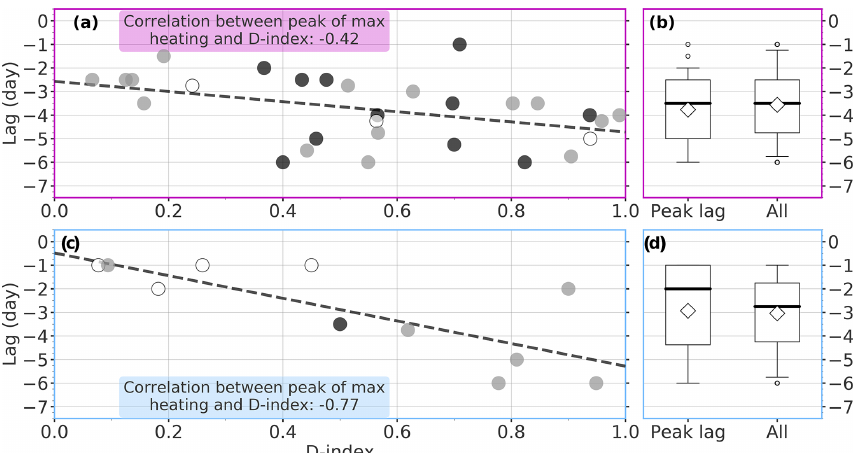
Figure 12. Correlation between life stage of the Ural (first row, magenta) or Scandinavian (second row, light blue) blocks and the time lag of peak heating within the main Atlantic (A) heating domain (a, c) ; markers colored by the Ural (a) and Scandinavian (b) sector blocking fraction (dark-gray marker > 99th percentile, white marker < 90th percentile and gray in between) at trajectory starting points (see also Tables S1–S4 in the Supplement, Sect. S1). The life stage of the block at the time of trajectory initialization is given by the D index (see Eq. 1). (b, d) The distribution for the time of peak heating in the Atlantic sector (total of 29 blocks in panel b and 11 blocks in panel d ) and the distribution of the time lag of peak heating defined separately for all trajectories experiencing maximum heating in the selected Atlantic sector (total of 38825 trajectories in panel b and 11692 in panel d ) are shown in boxplots. The horizontal line denotes the median, the diamond the mean, the box the interquartile range, the whiskers the 5th–95th range and the circles the